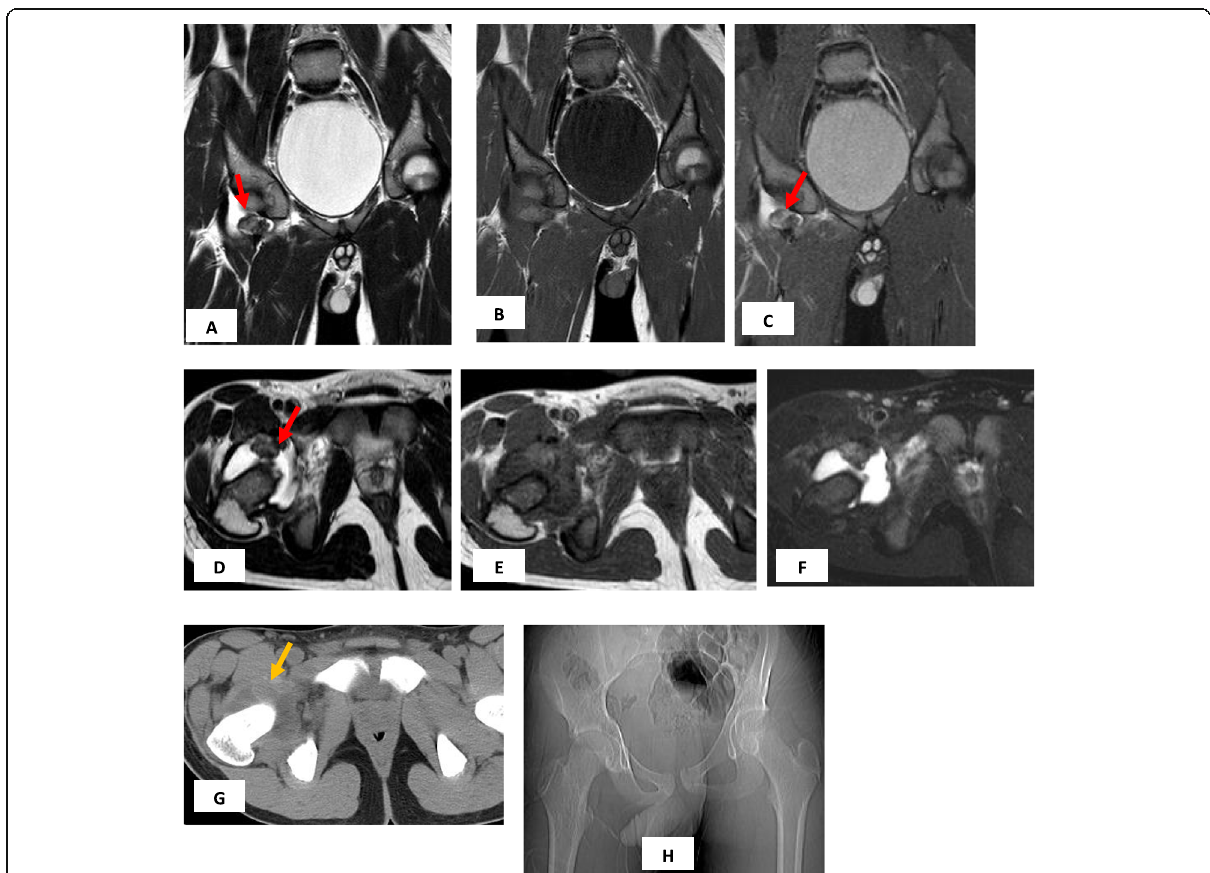
Fig. 7 Right hip post traumatic synovial hematoma in 25-year-old male. Coronal T2 ( a ), T1WI ( b ) and STIR ( c ), axial T2 ( d ), T1 ( e ), and STIR ( f ) show low signal mass-like synovial lesion (red arrows) with low signal intensity of hemosiderin and associated joint effusion. Axial CT ( g ) shows high density hematoma (yellow arrow). X-ray of the pelvis ( h )